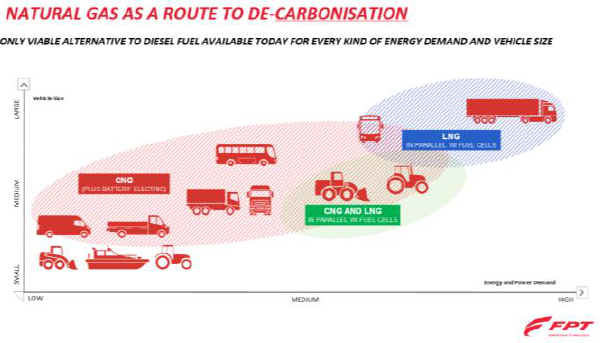
Fig. 8. Schematic of the relationship between vehicle size, energy demand and broad categories of most appropriate fuel type [39]